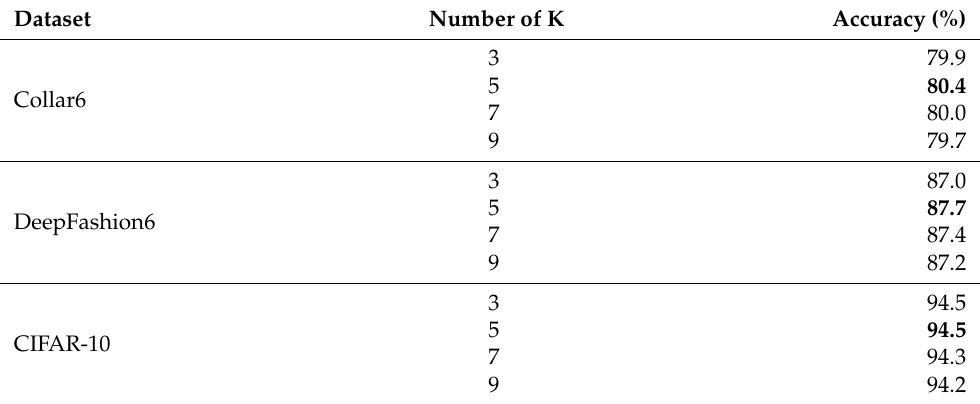
Table 10. The value of hyperparameter K affects the accuracy of the